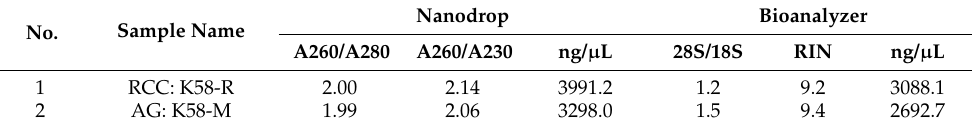
Table 1. Results of the RNA sample quality